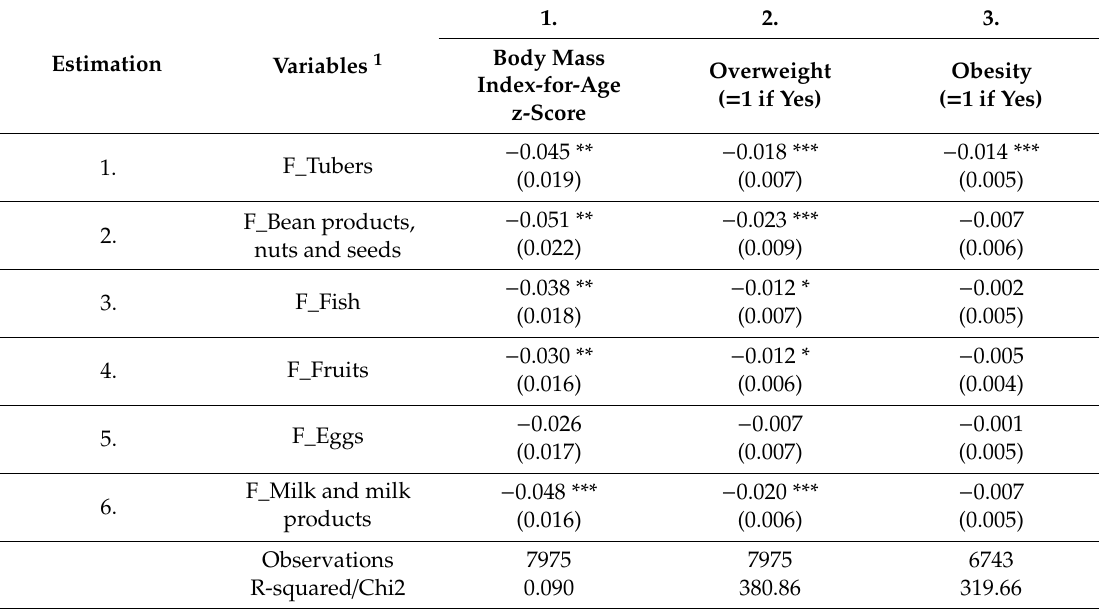
Table 8. The correlation between nutrition outcomes and the frequency of six main food groups.